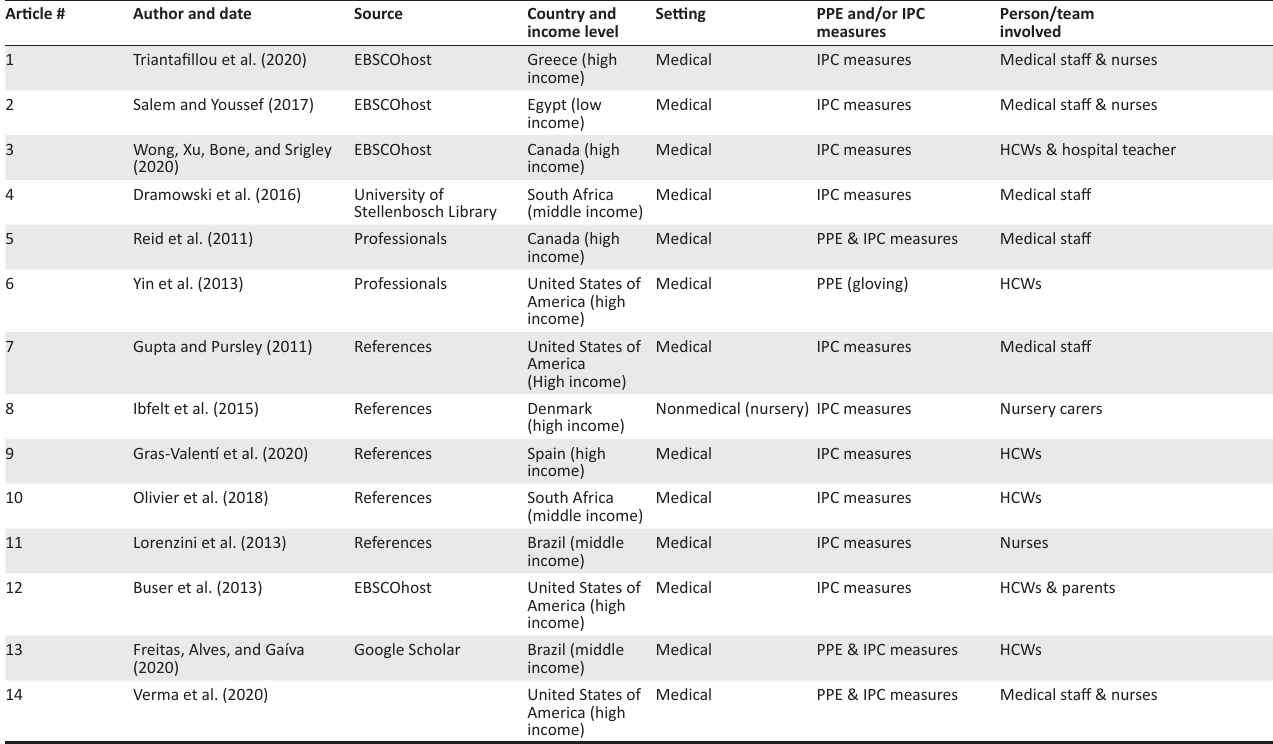
TABLE 1-A4: Characteristics of included